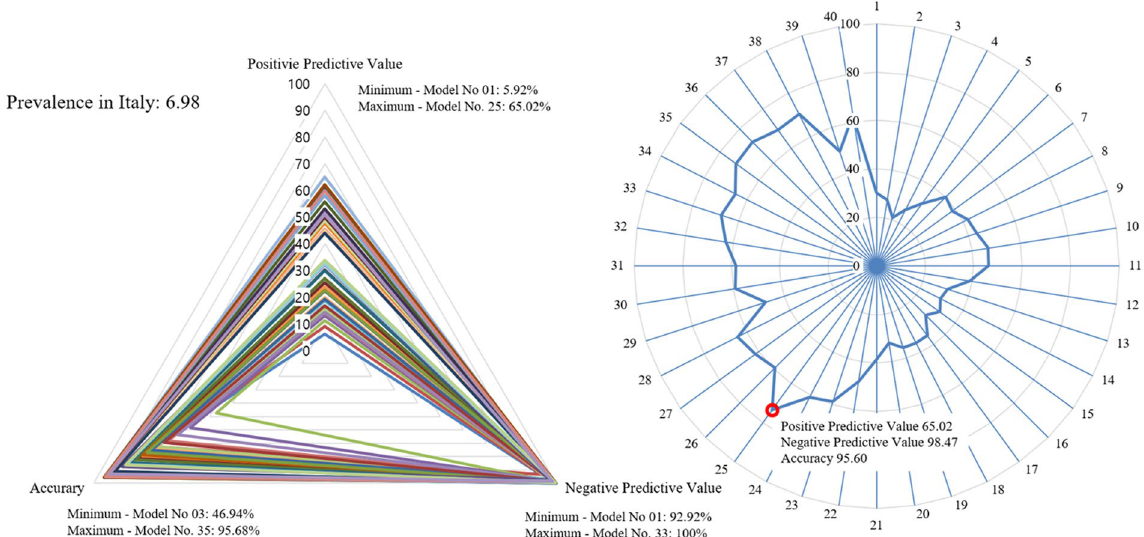
Figure 5. Comparison of each model considering screening performance affected by prevalence: Italy. Triangle radar chart: positive predictive values, negative predictive values and accuracy of each model; polygonal radar chart: triangle radar chart area ratio in each model.